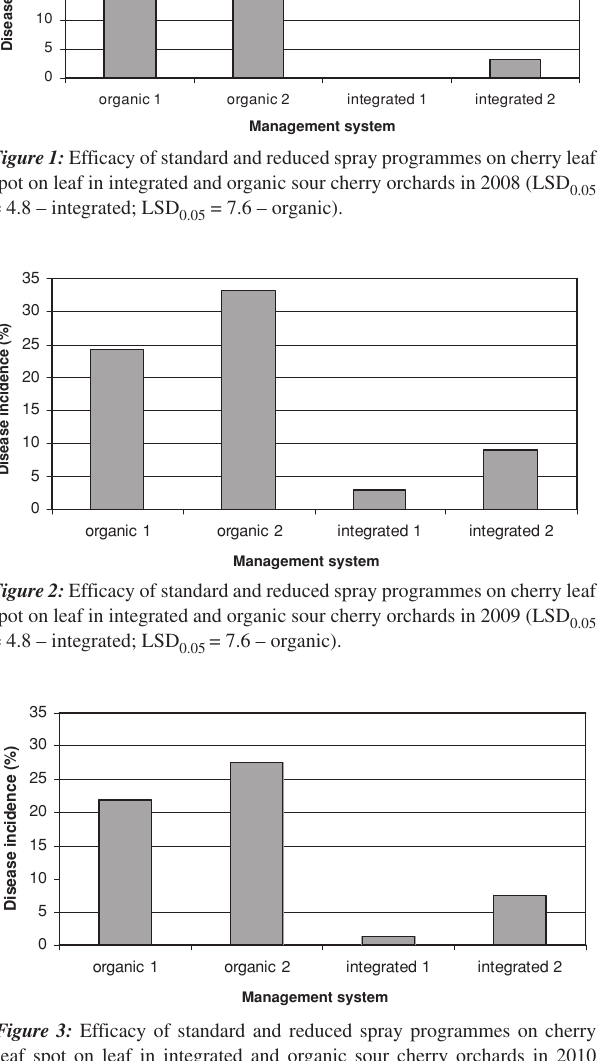
Figure 3: Efficacy of standard and reduced spray programmes on cherry leaf spot on leaf in integrated and organic sour cherry orchards in 2010 (LSD = 4.8 – integrated; LSD = 7.6 – 0.05 0.05